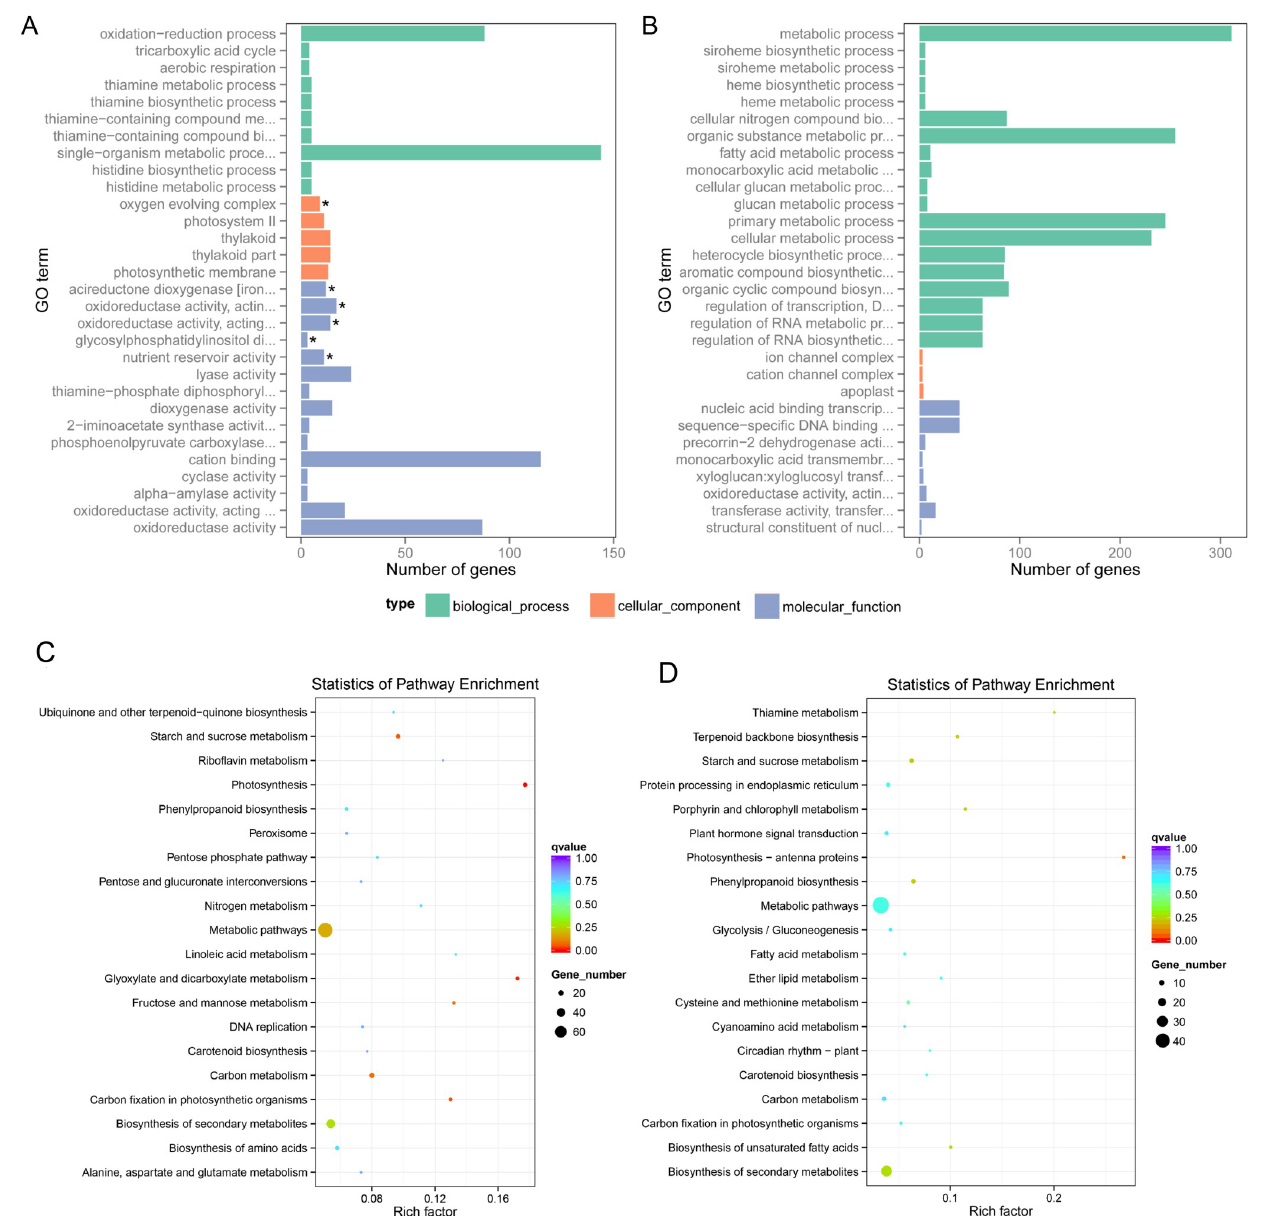
Fig 3. Functional analysis of cold responsive genes. A . GO enrichment analysis of the DEGs in 33S rice seedlings after seven days of low-temperature treatment. B . GO enrichment analysis of the DEGs in Nipponbare rice seedlings after seven days of low-temperature treatment. The DEGs were classified into three main GO categories (biological processes, molecular functions and cellular components). C . KEGG pathway enrichment analysis of DEGs in 33S rice seedlings after seven days of low-temperature treatment. D . KEGG pathway enrichment analysis of DEGs in Nipponbare rice seedlings after seven days of low-temperature treatment. The P-value to determine the enrichment significance was calculated through hypergeometric distribution.